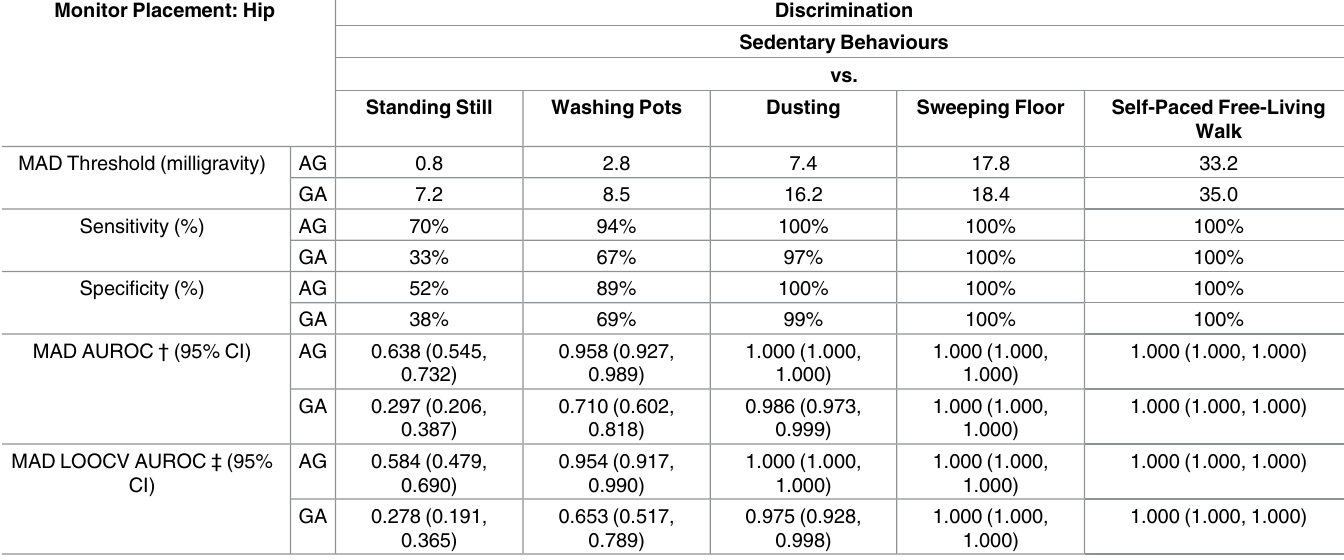
Table 6. Monitor-specific hip Mean Amplitude Deviation (MAD (measuredin milligravity units)) thresholds to differentiate between sedentary behaviours and light-intensity physical activities. Monitor Placement: